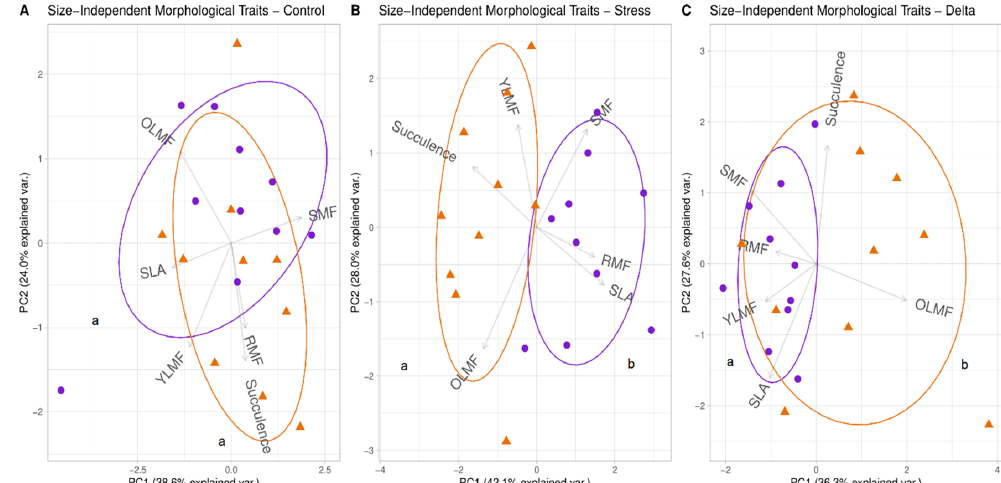
Figure 3. Principal component analyses (PCA) of the six size-independent morphological traits, which include specific leaf area (SLA) and leaf succulence per area and the four tissue type mass fractions (Young Leaf Mass Fraction (YLMF), Old Leaf Mass Fraction (OLMF), Stem Mass Fraction (SMF), and Root Mass Fraction (RMF)) under ( A ) Control conditions, ( B ) Stress conditions, and ( C ) Delta (the change between treatments). Purple circles indicate cultivated accessions and orange triangles indicate wild accessions. Different lower-case letters denote significant Hottelings-T2 test for differences ( p < 0.05) between the two domestication status groups.